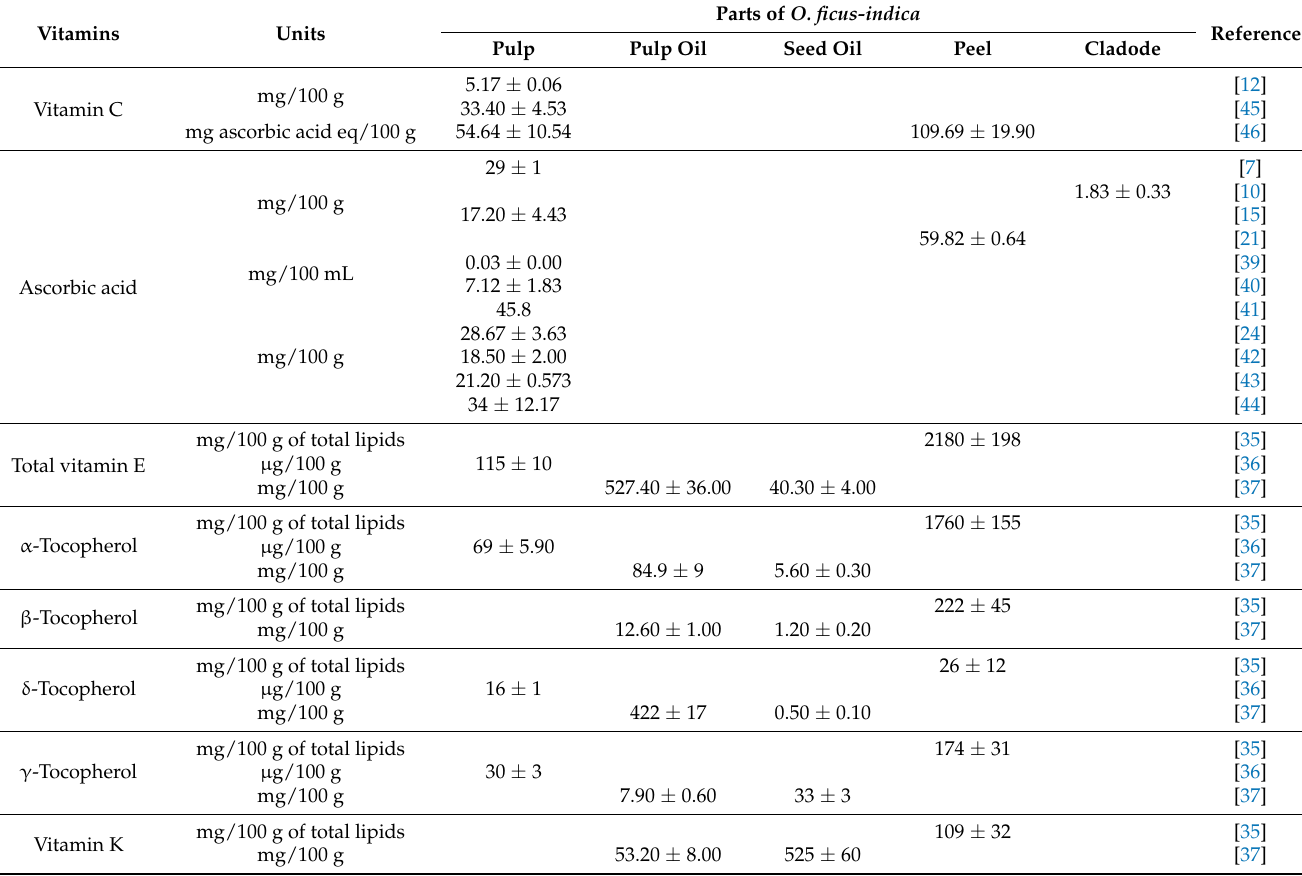
Table 3. Vitamins content of the different parts of Opuntia ficus-indica (L.)